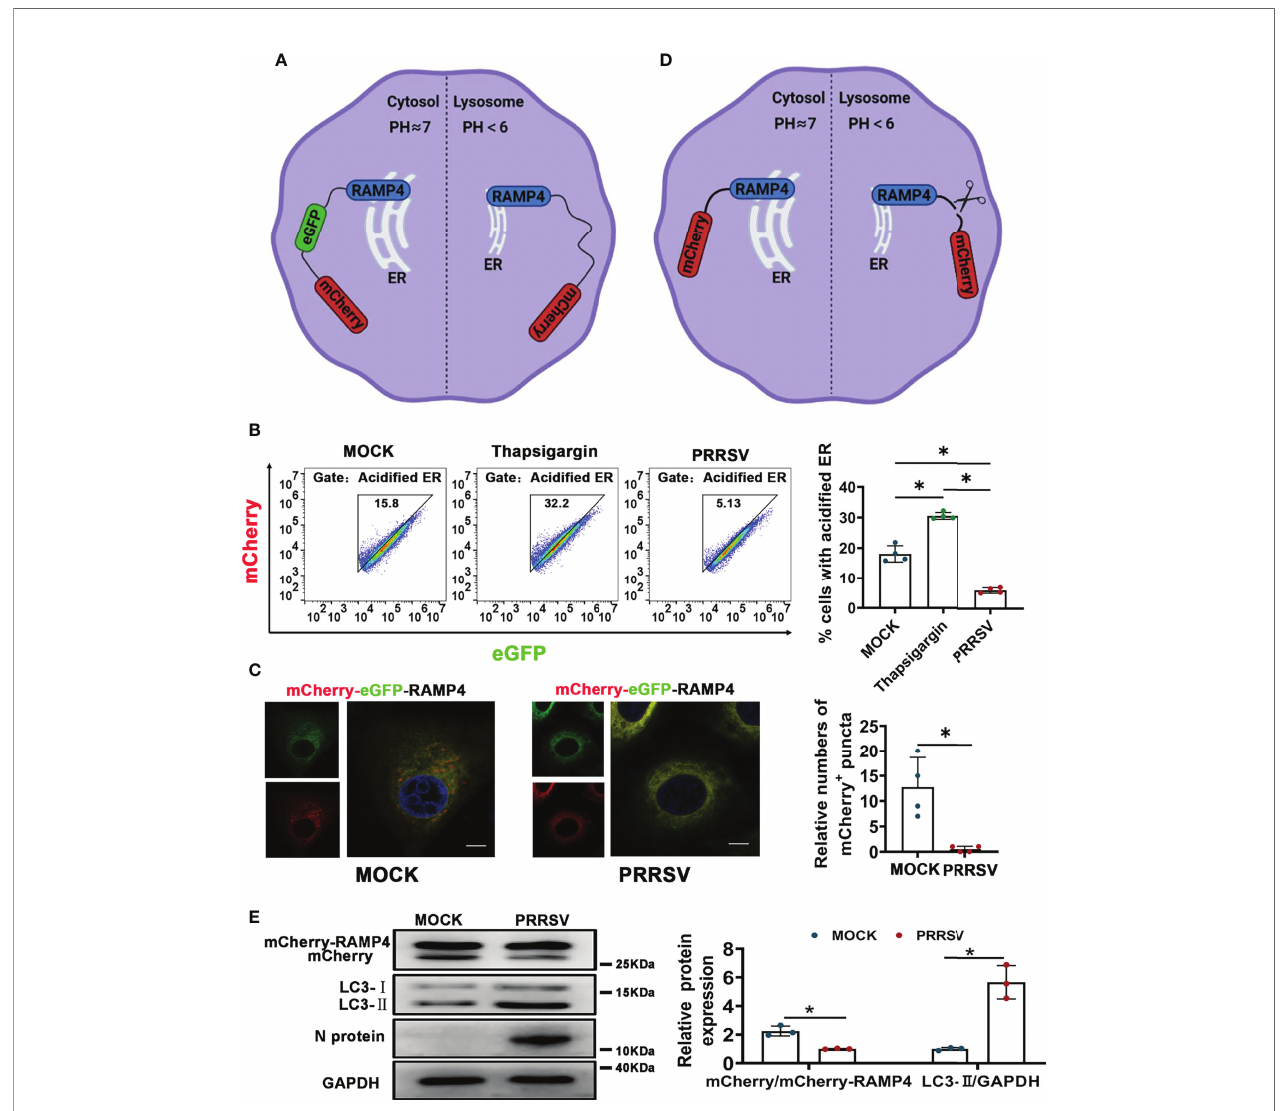
FIGURE 2 | CCER and EATR assays of ER-phagy. (A) Schematic representation of EATR assay. The quenching of eGFP signaling in mCherry-eGFP-RAMP4 reporter indicated the occurrence of ER-phagy. (B) Flow cytometry analysis of EATR system infected with PRRSV (MOI=1) or treated with thapsigargin (0.5uM, positive control) for 48 h. * P <0.05, Kruskal Wallis test, n=4. (C) Confocal images of EATR system infected with PRRSV (MOI=1) for 48 h. mCherry + puncta were counted. Scale bars: 20 m m. * P <0.05, Wilcox test, n=4. (D) Schematic representation of CCER assay. The cleavage of RAMP4-mCherry to form free mCherry suggested the occurrence of ER-phagy. (E) Expression of mCherry, mCherry-RAMP4, LC3-I, and LC3-II proteins in PK15 CD163 cells transfected with mCherry- RAMP4 vector. The relative ratio of mCherry/mCherry-RAMP4 and that of LC3-II/GAPDH in PK15 CD163 cells infected with PRRSV (MOI=1) for 36 h were calculated. GAPDH served as the control. * P <0.05, Kruskal Wallis test,